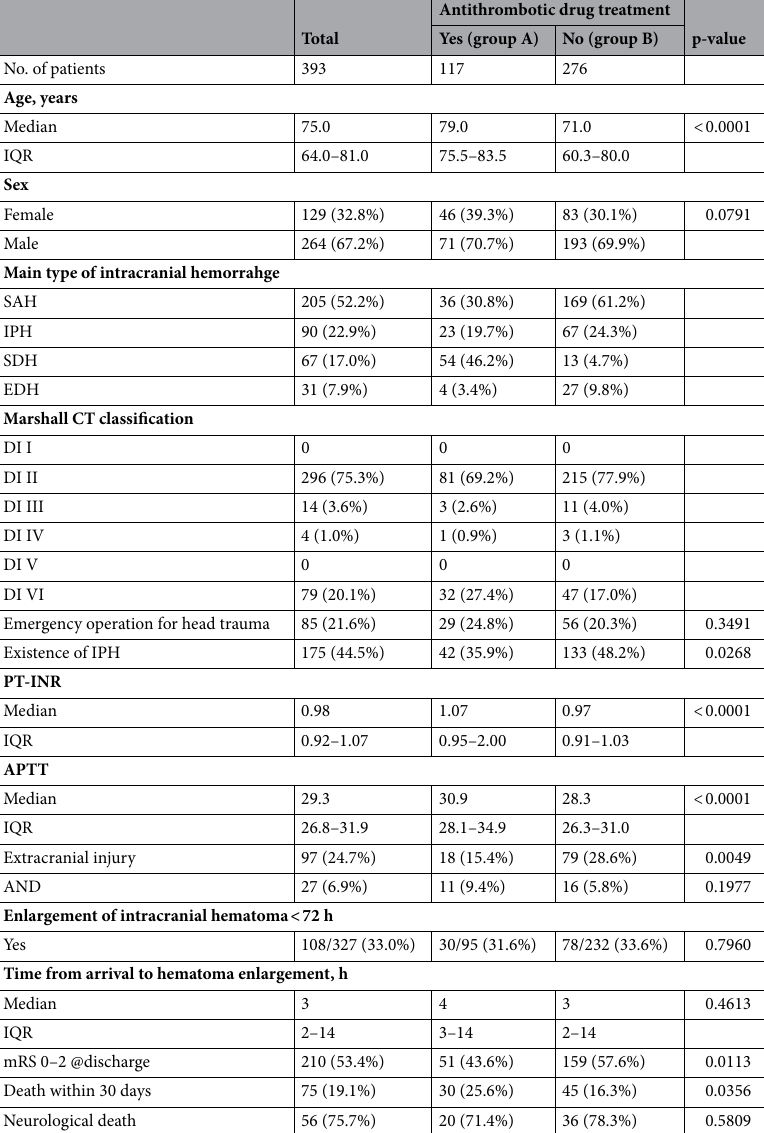
hematoma, IPH intraparenchymal hemorrhage, IQR interquartile range, mRS modified Rankin scale score, PT-INR prothrombin time (international normalized method), SAH subarachnoid hemorrhage, SDH subdural